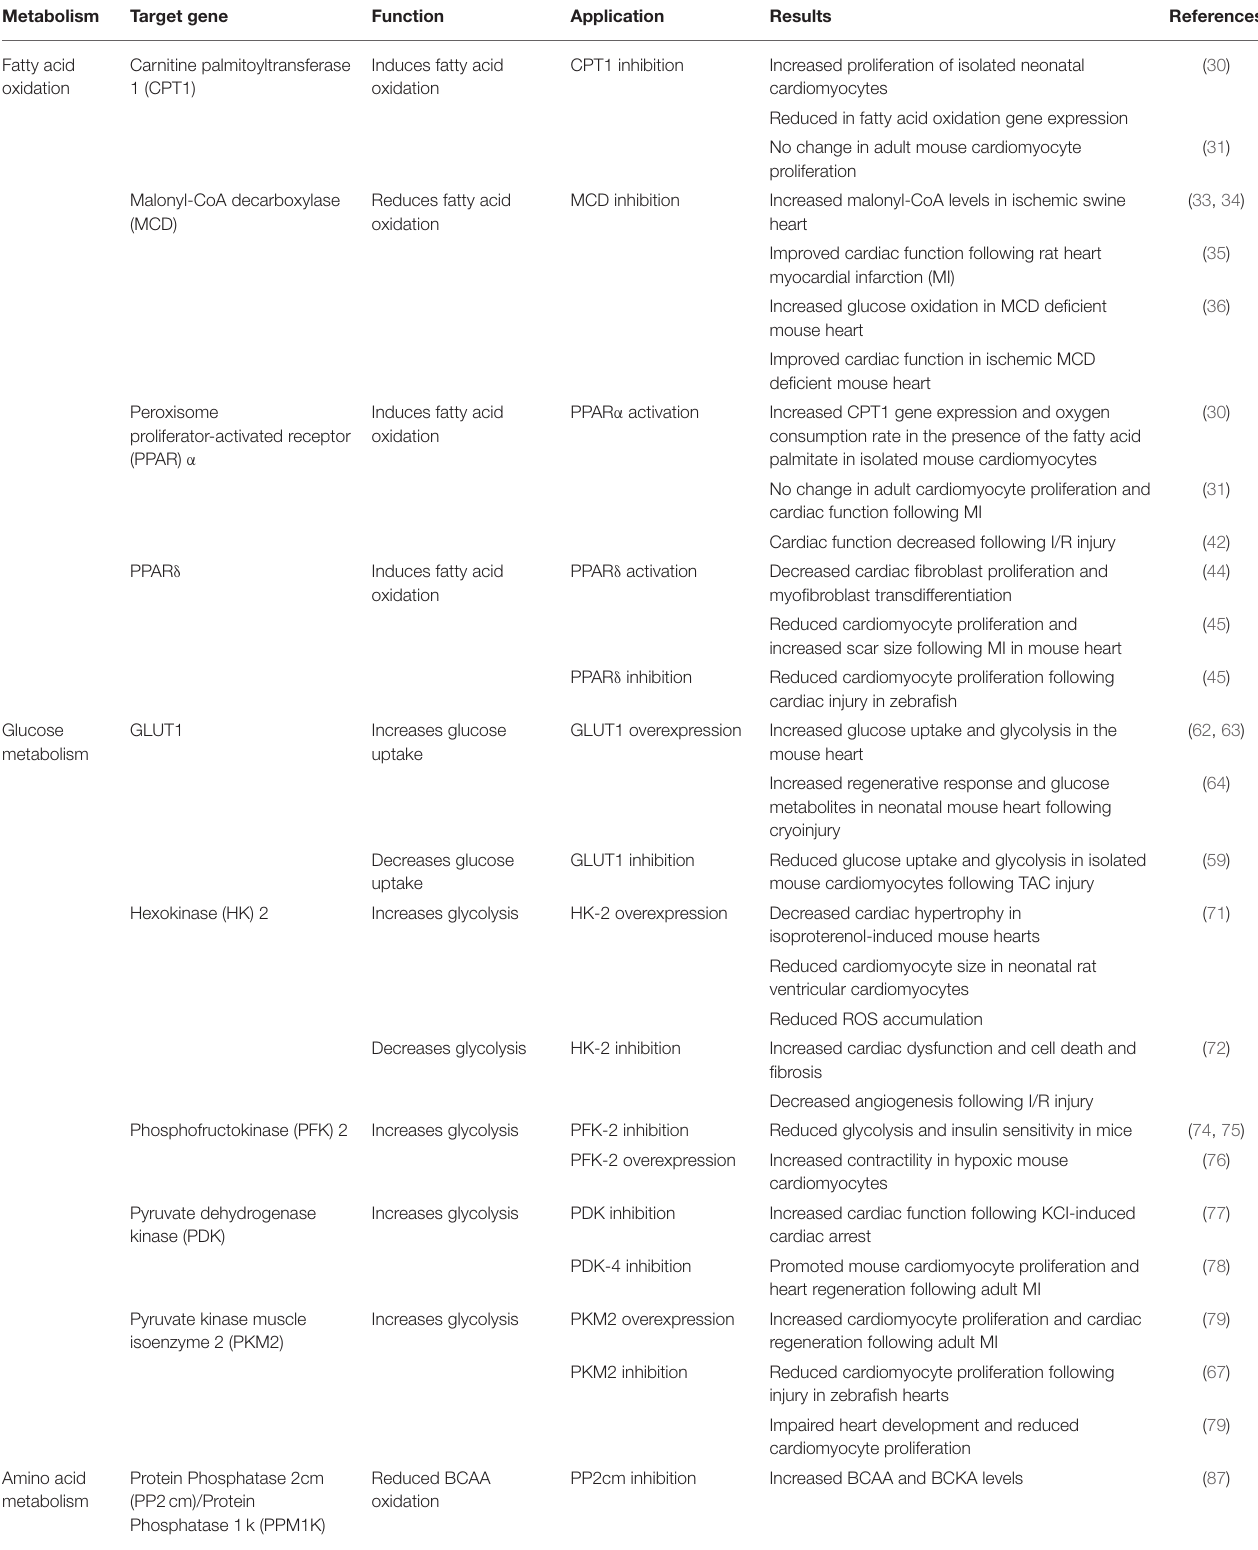
TABLE 1 | Summary of recent studies demonstrating a central role for metabolism in heart failure and regeneration.